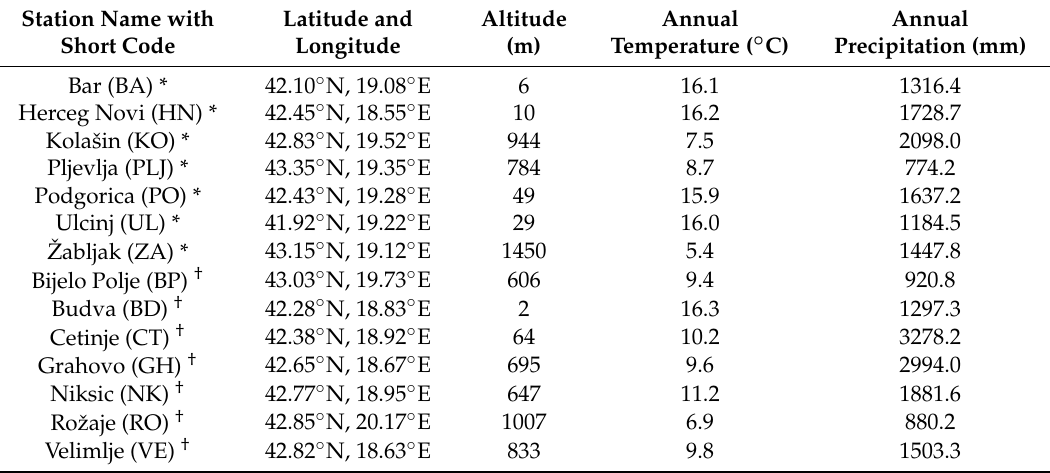
The geographical position and climate characteristics (1981–2010) of the selected locations (*—Stations included in the MCDA mosquito model; † —Stations included in the Köppen climate